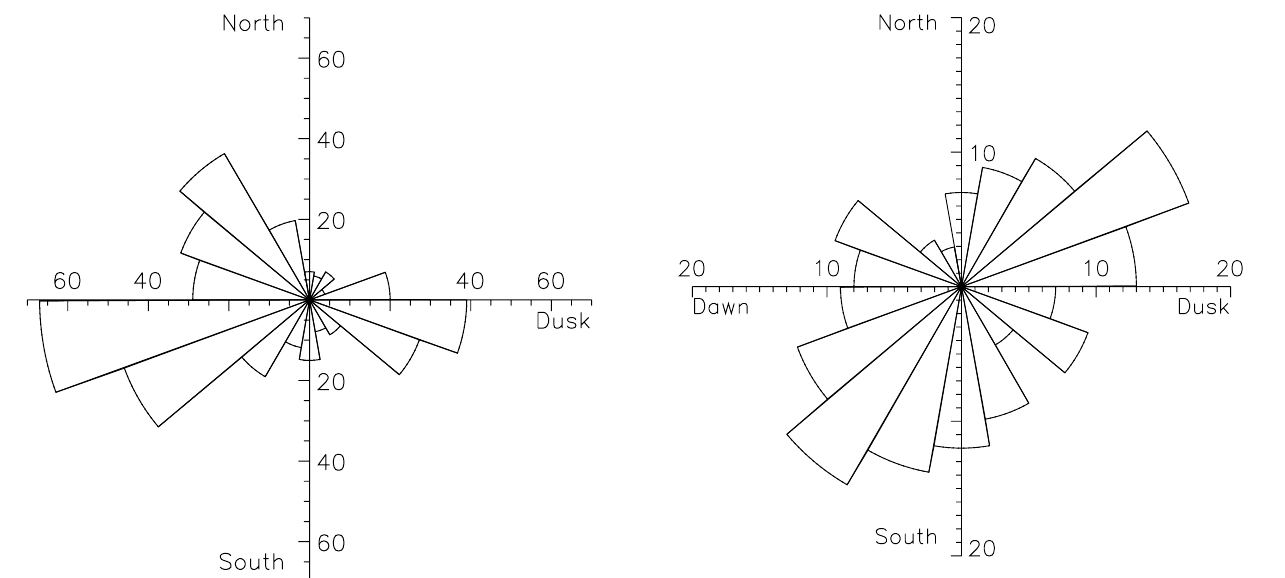
Fig. 1. A polar histogram of the lagged IMF clock angle at the time of observation of each FTE. The angle clockwise from north is the IMF clock angle; hence the angles are those as viewed from the Sun. North and south ( ± Z GSM ) are at the top and bottom, and dusk & dawn ( ± Y GSM ) are right & left. Each bin is 20 ◦ wide.